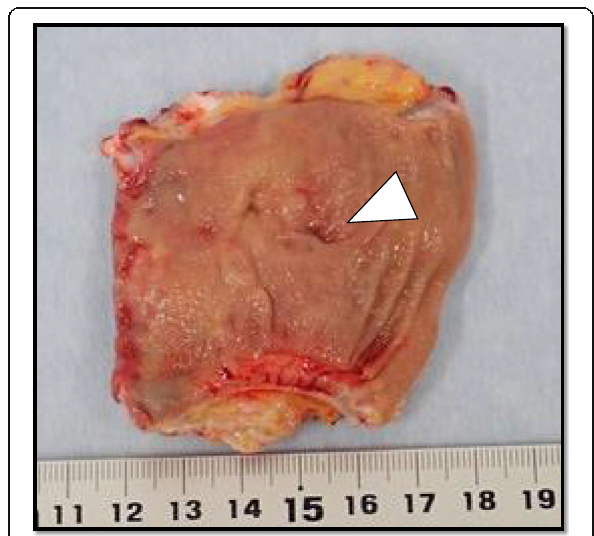
Fig. 5 The specimen was not malignant and a 0.5 cm × 0.5 cm perforation hole in the mesenteric side of the stoma limb was seen